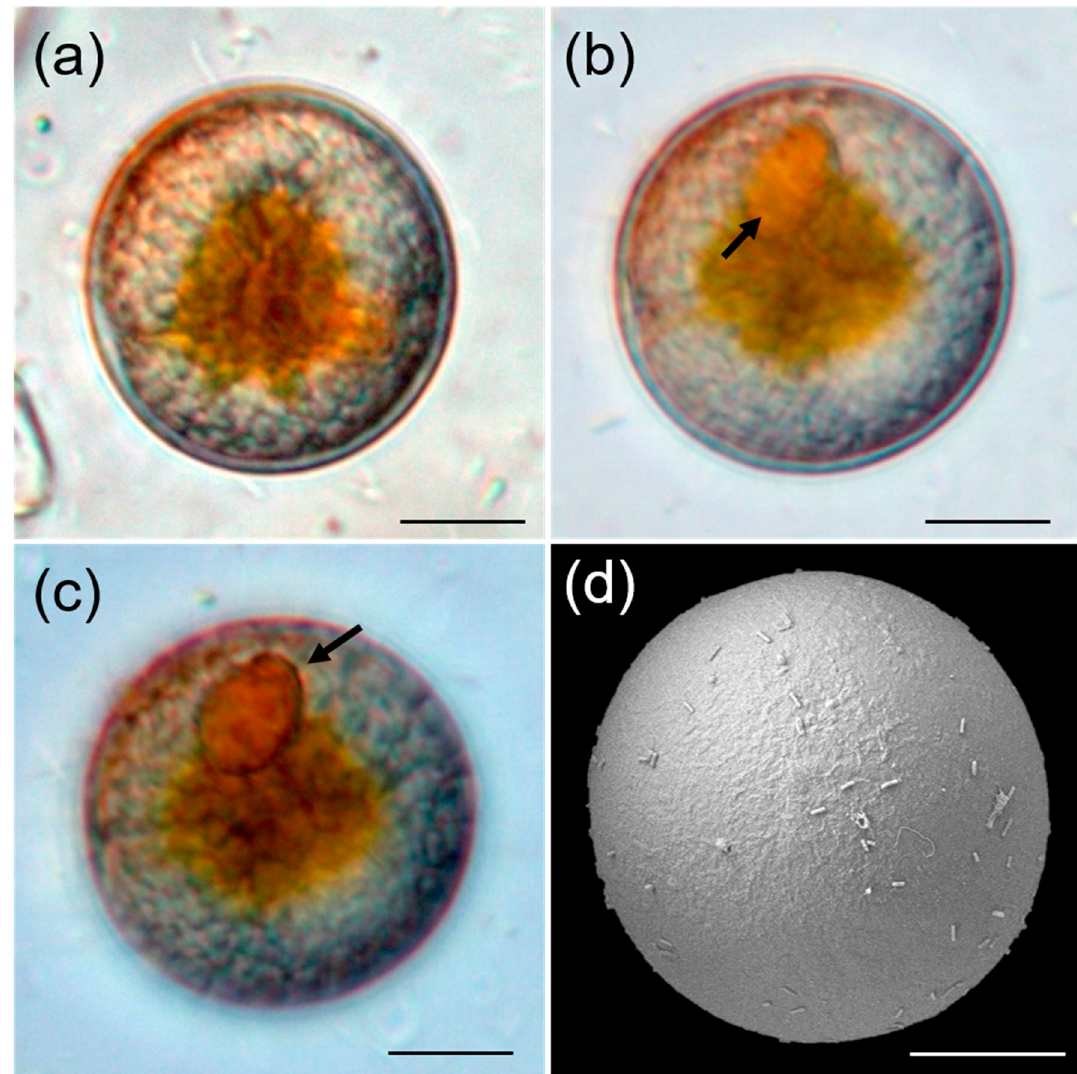
Figure 3. Light and scanning electron micrographs of cysts of Bysmatrum subsalsum strain LIMS-2685. ( a ) Light micrographs of spherical cyst. ( b , c ) Light micrographs of cysts showing large, orange, accumulation body (arrows). ( d ) Scanning electron micrograph showing a smooth organic wall without any ornamentation. Scale bars = 5 µm.